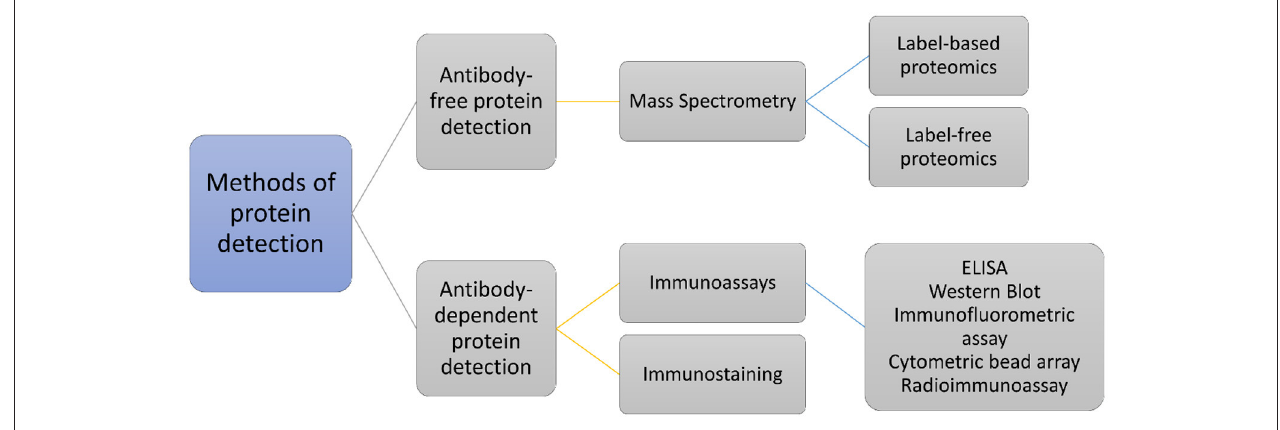
FIGURE 1 | Methods applied in endodontic literature to detect biomarkers at the protein